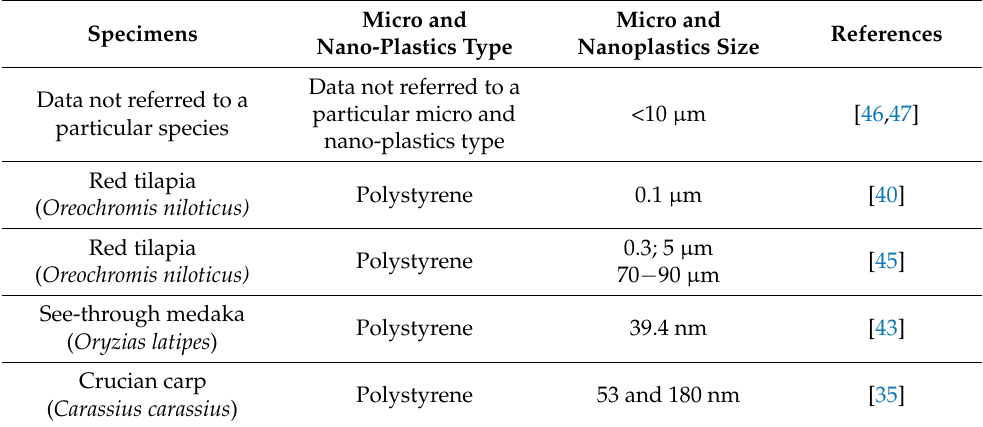
Table 1. Micro and nanoplastics crossing the blood brain barrier in